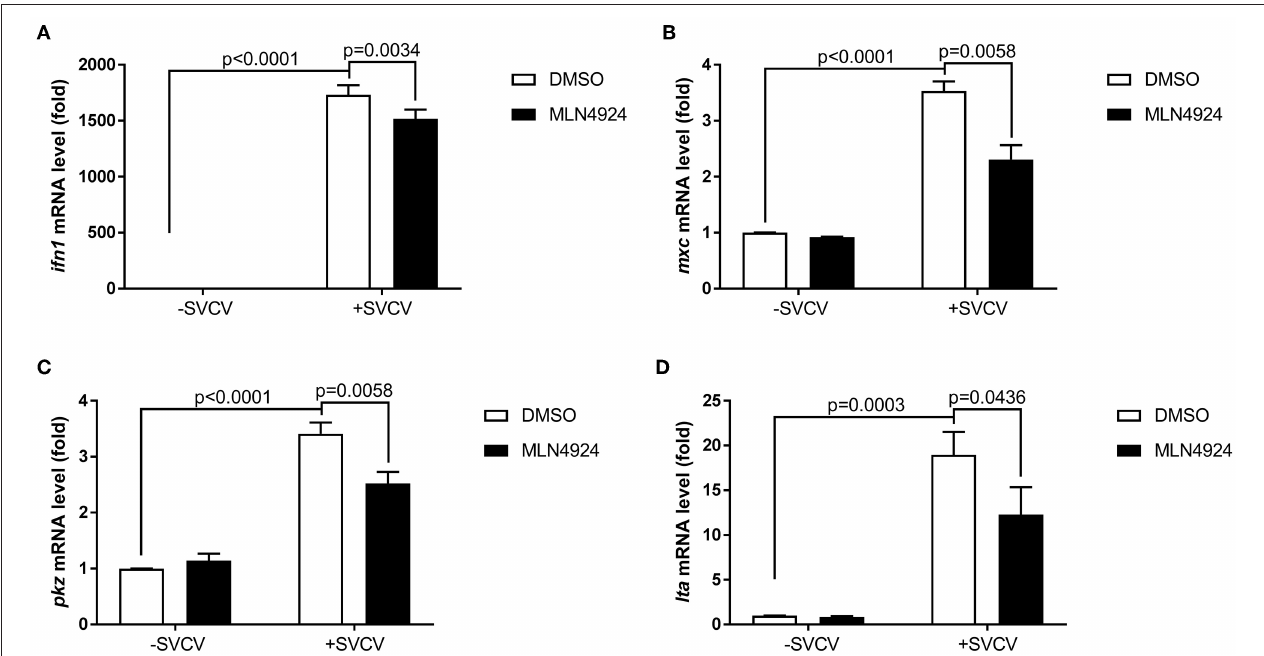
FIGURE 4 | MLN4924 suppresses SVCV-induced activation of key antiviral genes in zebrafish larvae. (A–D) The expression levels of ifn1 (A) , mxc (B) , pkz (C) , and lta (D) after SVCV infection were lower in zebrafish larvae treated with MLN4924 as compared to larvae treated with DMSO (control). Zebrafish larvae (three days post-fertilization, dpf) were infected with SVCV ( ∼ 2 × 10 8 TCID 50 /ml) after pretreatment with either vehicle (DMSO) or MLN4924 (1 µ M) for 24h. After 24h incubation, we extracted total RNA from all larvae and used qPCR assays to detect the expression levels of inf1 , mxc , pkz , and lta . Data are shown as mean ± SEM of three independent experiments, each performed in triplicate; the statistical analysis was performed using GraphPad Prism 5 (unpaired t -test).